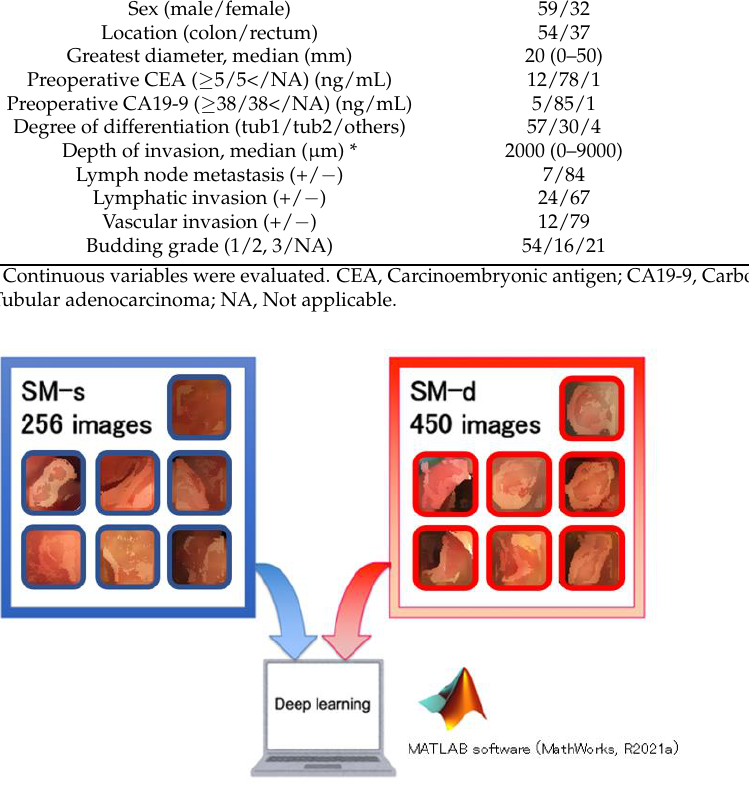
Figure 2. The computer used the 706 images learned by the computer for CNN analysis. The number of SM-s images was 256 and the number of SM-d images was 450. Table 2. Clinicopathological features (Learning set 2011 – 2015).